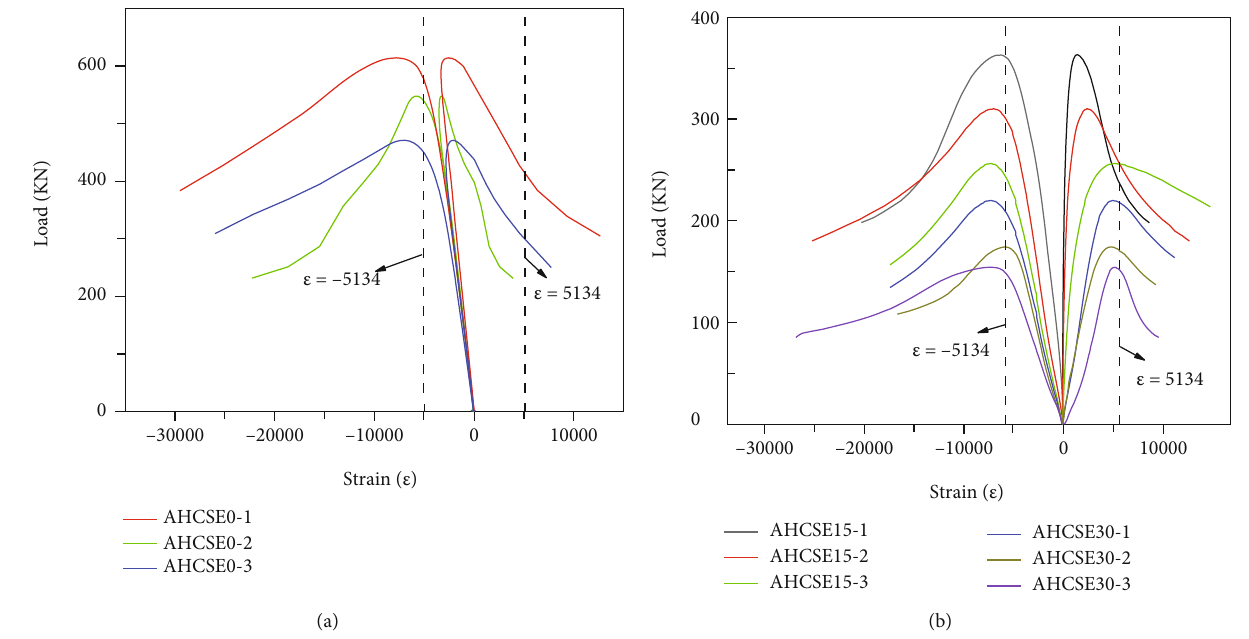
Figure 7: (a) Axial compression specimen. (b) Eccentric compression